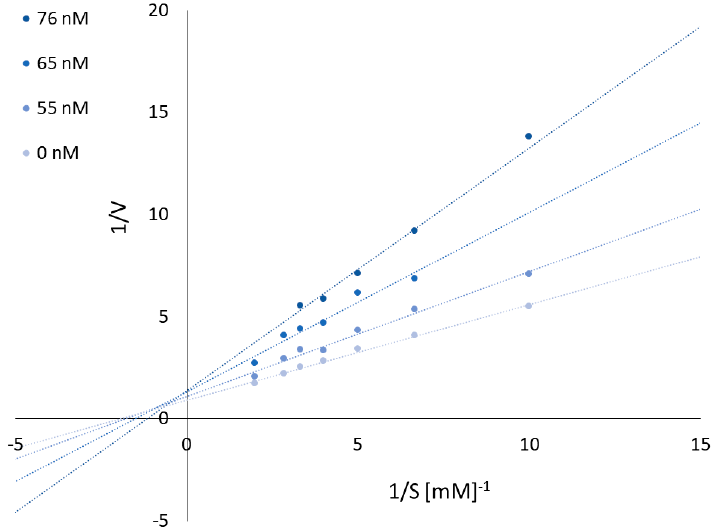
Table 1. Inhibitory effects of compounds 3a – 3h against AChE and BuChE activity and on d radical scavenging activities.